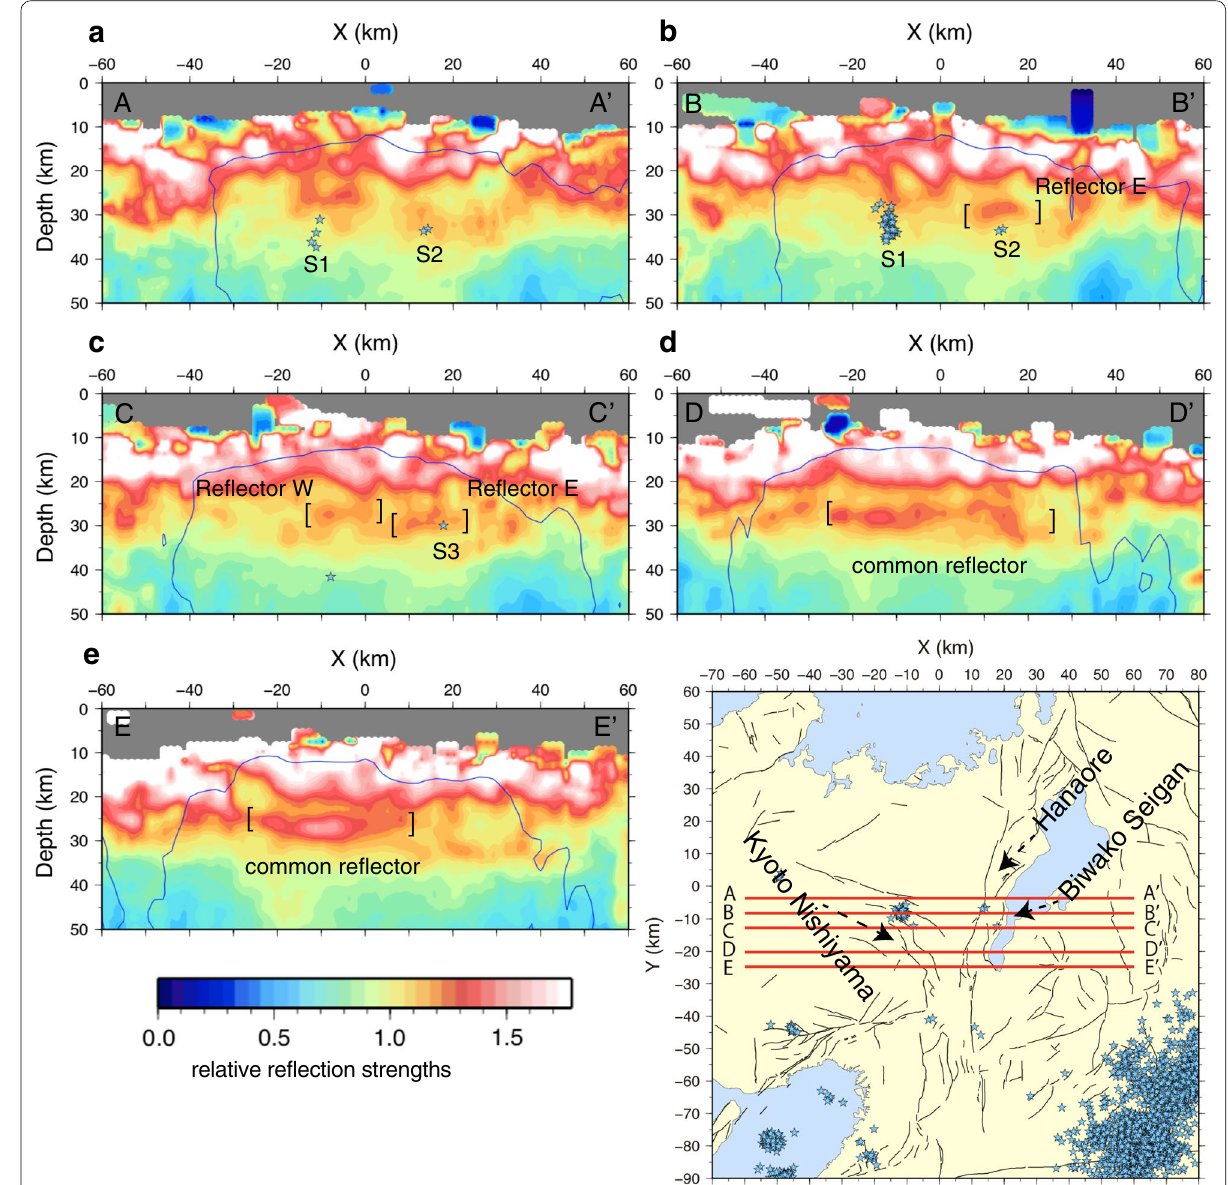
Fig. 5 Relative reflection strengths along EW vertical cross section. The location of cross section is shown in the lower right-hand side of the figure. Blue stars represent hypocenters of DLFs occurring within 5 km of each cross section. Black lines represent active faults. The assumed angle of inclination is shown at the upper left-hand side in each panel. Blue lines show regions in which the number of data points assigned to each grid cell exceeds 10,000. We consider that relative reflection strengths within blue lines are sufficiently accurate. The names of the fault zones [Kyoto Nishiyama, Hanaore, and Biwako Seigan] are putted near each fault zone in the inset